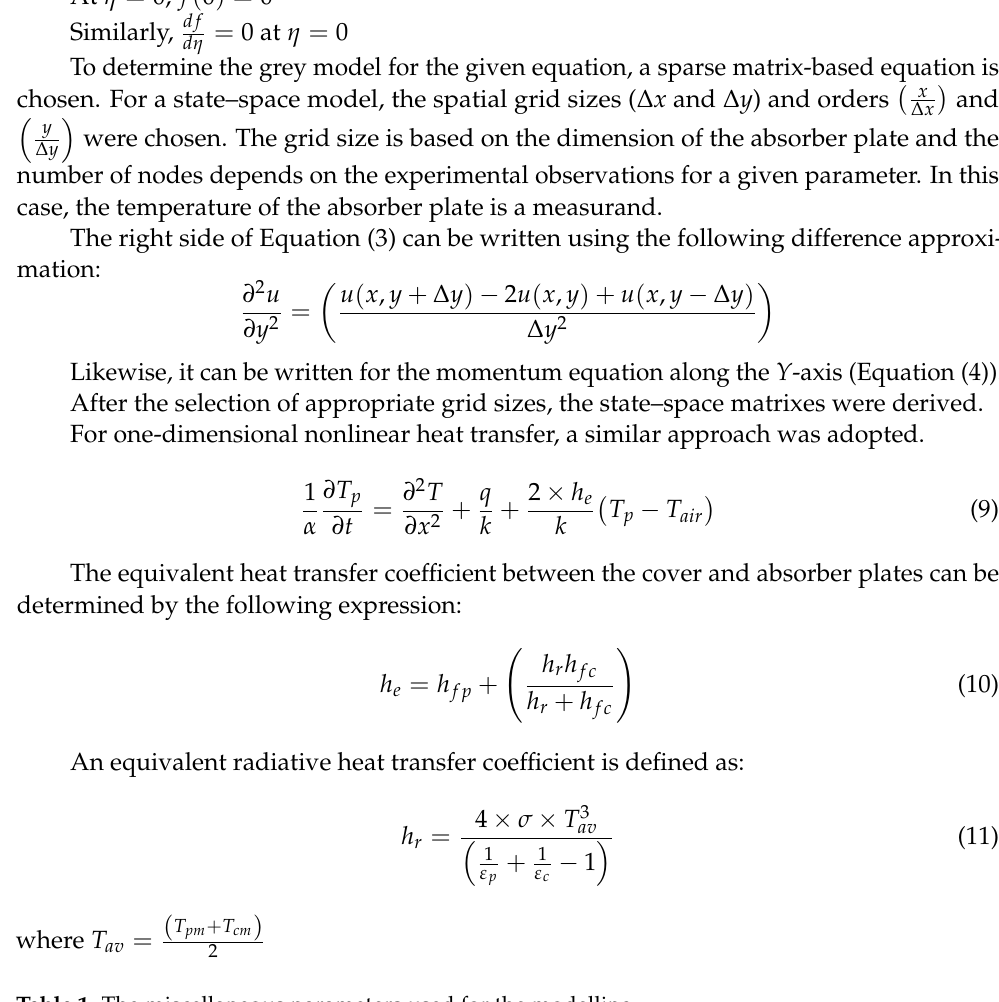
Table 1. The miscellaneous parameters used for the modelling. Parameters With